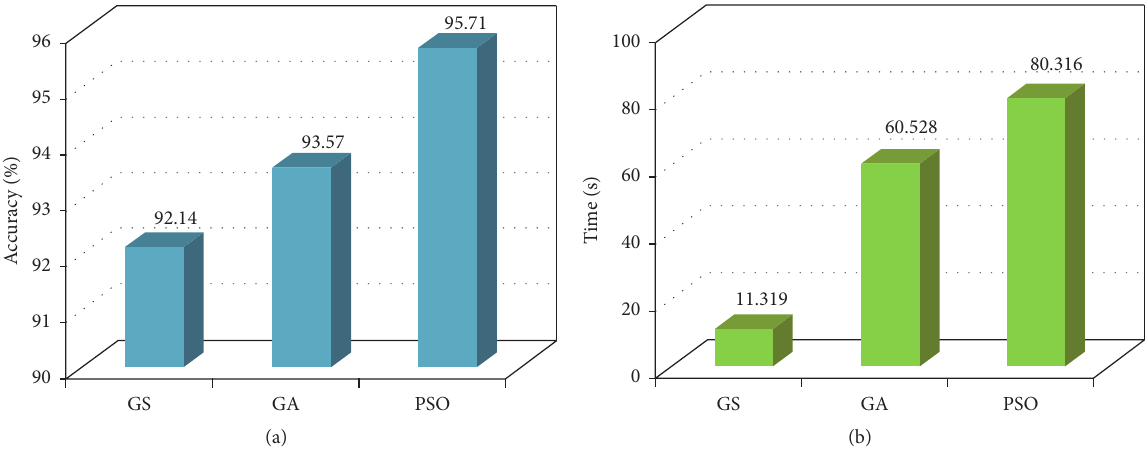
Figure 11: (a) The diagnostic accuracy based on the LS-WSVM optimized by PSO, GA, and GS, respectively; (b) the consuming time of PSO, GA, and GS,